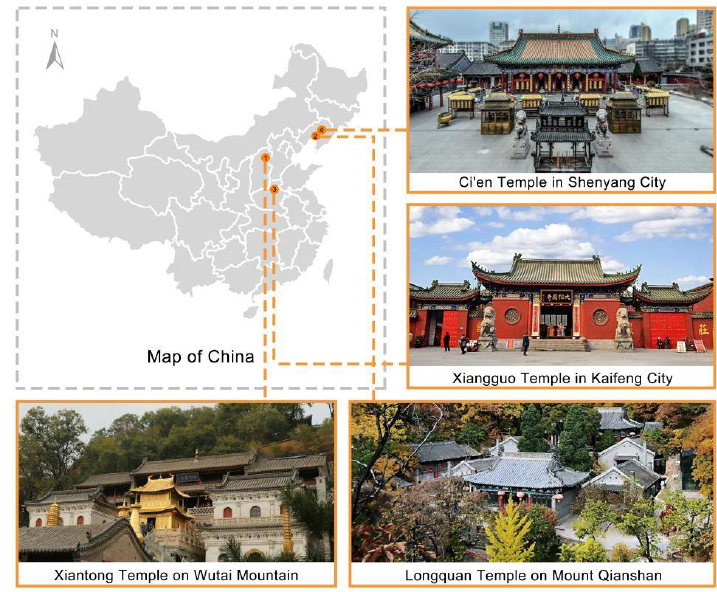
Figure 1. Location and surrounding environment of the four